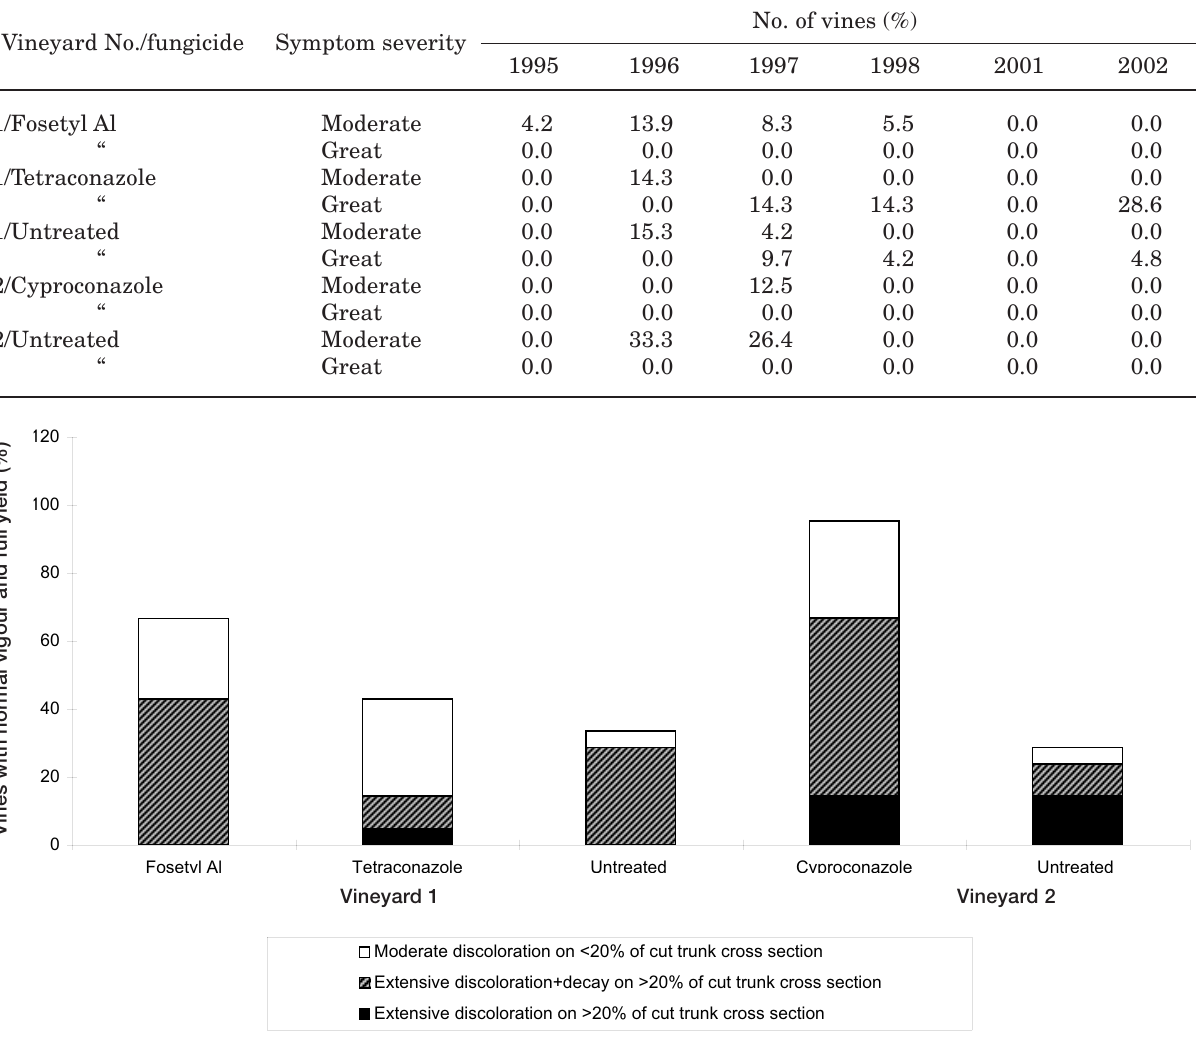
Fig. 2. Severity of wood necrosis (%) observed at the time of trunk renewal (1995) in vines showing normal vigour and full yield eight years later